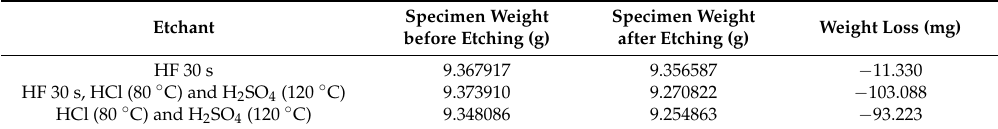
Figure 5. The comparison of the weight loss of Ti/Ti-6Al-4V ELI for different etchant solutions after etching at BT. Table 6. The difference in weight loss between etching with/without HF treatment. Etchant